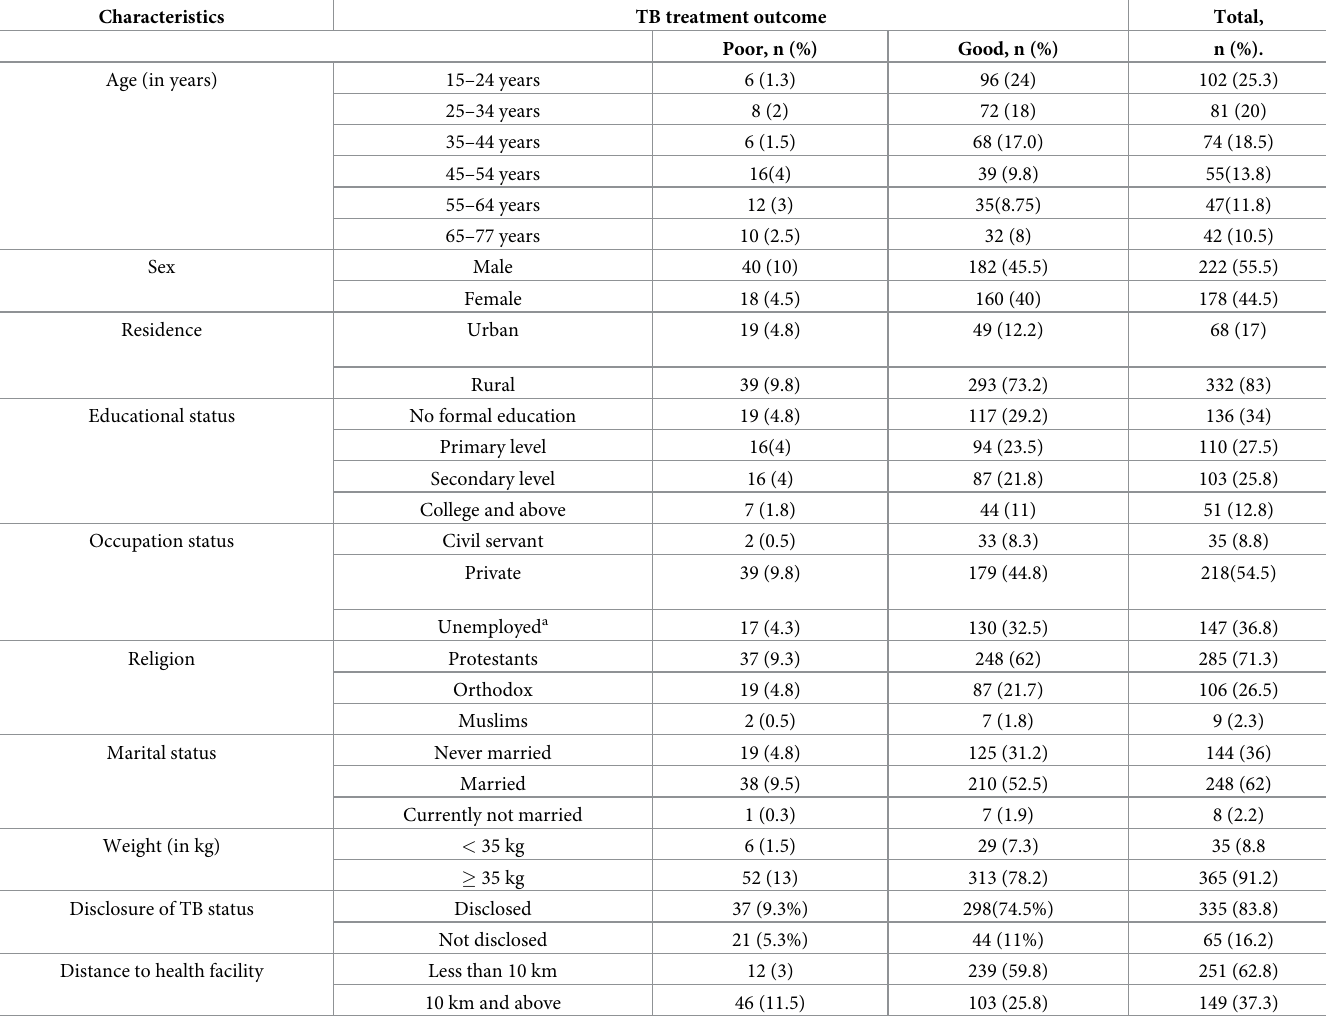
Table 1. Socio-demographic characteristics among adult patients registered at Gibe Woreda public health facilities, Hadiya zone, Southern Ethiopia from 1 st Janu- ary 2017 to 31 st December 2019.